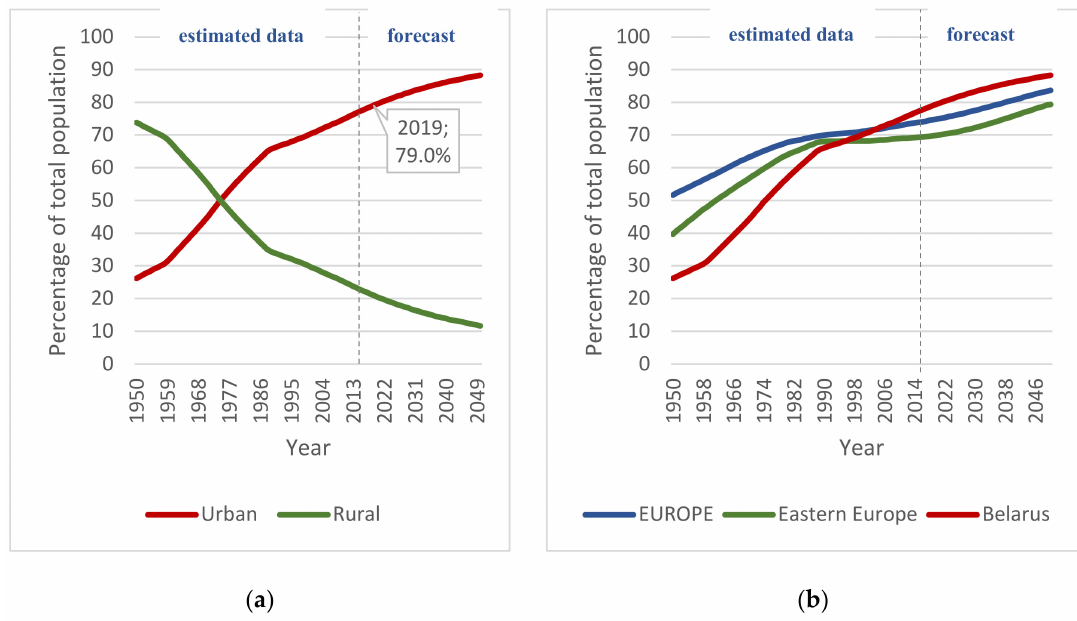
Figure 1. Percentage of population, from 1950 to 2050, living in ( a ) urban and rural in Belarus; ( b ) urban by region and subregion [43]. Table 1. Population census data in Belarus (from the end of the XIX century to the present